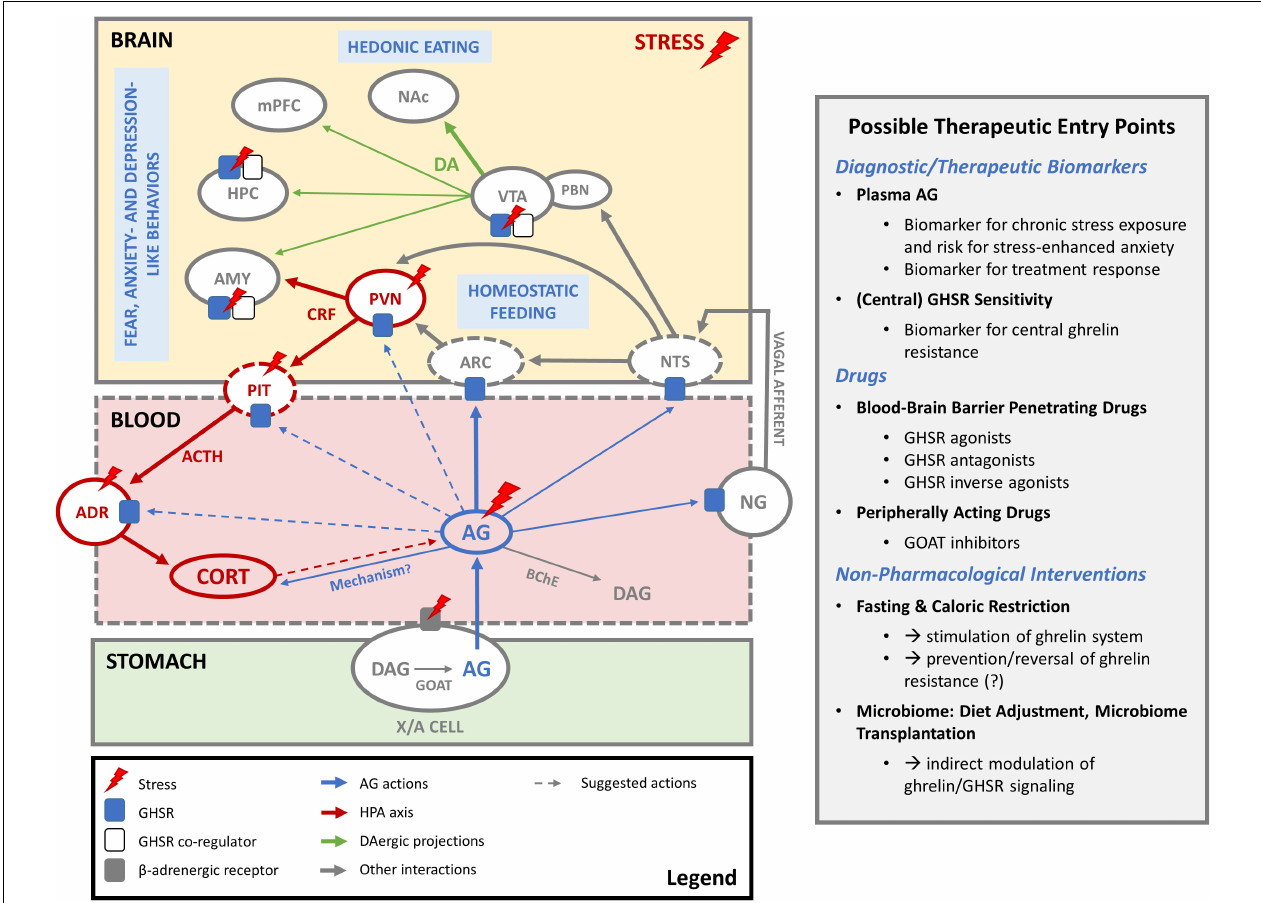
FIGURE 1 | The ghrelin system in stress coping. In periods of hunger and stress, AG is produced by acylation of DAG by GOAT in gastric X/A cells and released into the blood stream. Before it is degraded to DAG, it acts on GHSR in the arcuate nucleus of the hypothalamus (ARC) to regulate homeostatic feeding. Increased AG levels during stress also seem to amplify HPA axis activation and induce corticosterone (CORT) release. The exact mechanism is not clear and could involve indirect activation of CRF-producing neurons in the PVN by inhibition of the local GABAergic tone, modulation of ACTH production in the pituitary (PIT) or direct effects on the adrenal cortex (ADR). AG may also indirectly influence the HPA axis via GHSR in the nodose ganglion (NG) of the vagal nerve or in the nucleus tractus solitarius (NTS). Conversely, whether HPA axis activity during stress has an impact on ghrelin release remains a subject of debate. Elevated AG levels following stress may also be secondary to activation of the sympathetic nervous system and beta receptors on ghrelin-producing X/A cells. Whether AG can pass the blood-brain barrier to act on stress-relevant brain areas where GHSR are expressed is not clear. However, constitutive activity of central GHSR may be regulated via changes in GHSR expression levels or formation of heterodimers with other receptors (e.g., dopamine, serotonin) as co-regulators. Such mechanisms might play a role in stress-related changes in feeding and fear, anxiety- and depression like behaviors, possibly via GHSR in the ventral tegmental area (VTA), hippocampus (HPC) and amygdala (AMY). Also mesocorticolimbic dopaminergic projections (DA) of the VTA to nucleus accumbens (NAc), medial prefrontal cortex (mPFC), HPC and AMY may play a role here. Abbreviations: AG, acyl ghrelin; DAG, desacyl ghrelin; GOAT, ghrelin O-acyltransferase; BChE, butyryl cholinesterase; ARC, arcuate nucleus of the hypothalamus; PVN, paraventricular nucleus of the hypothalamus; CRF, corticotropin releasing factor; PIT, pituitary gland; ACTH, adrenocorticotropic hormone; CORT, corticosterone/cortisol; ADR, adrenal cortex; NTS, nucleus tractus solitarius; NG, nodose ganglion; VTA, ventral tegmental area; PBN, parabrachial nucleus; DA, dopamine; NAc, nucleus accumbens; mPFC, medial prefrontal cortex; HPC, hippocampus; AMY,